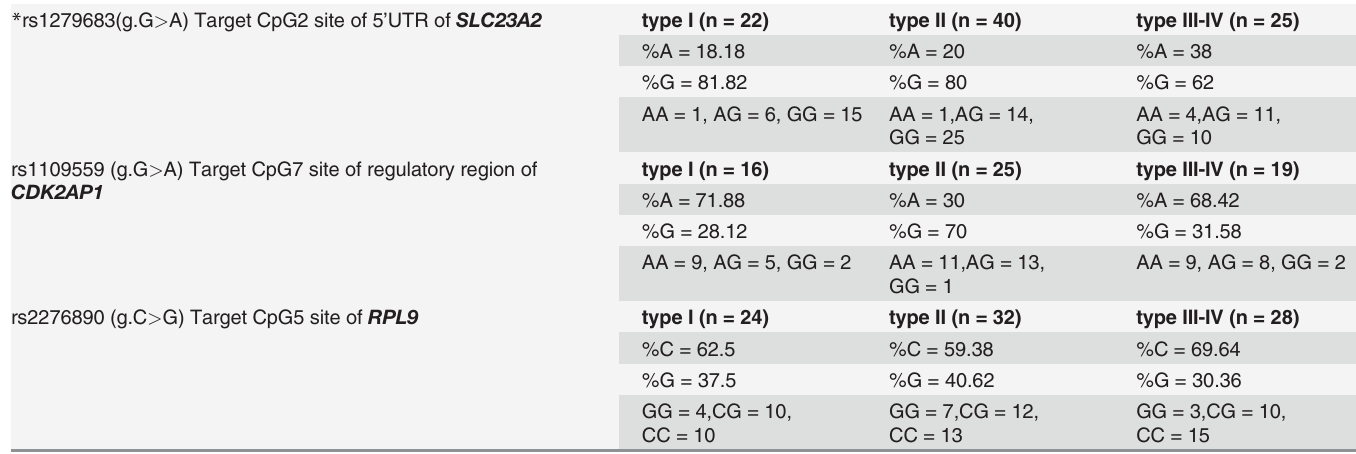
Relative expression levels of ARHGAP22 and NCOR2 It was also meaningful to assess the expression of genes chosen for the methylation level analy- sis. Relative expression analysis was performed for ARHGAP22 and NCOR2 because of insuffi- cient amount of biomaterial and low expression levels of some genes in blood cells. Highly Table 6. Allele and genotype frequency of SNPs rs1279683, rs1109559 and rs2276890 in SMA patients.